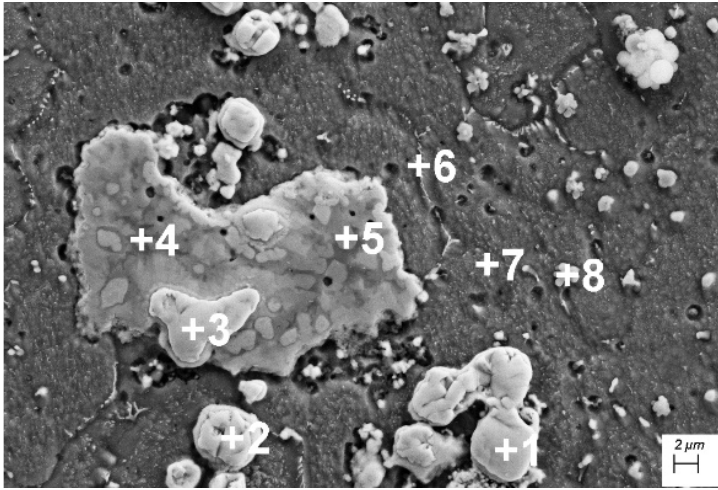
Figure 6. SE SEM image taken of the center area of the Cr75WC25 layer. Table 3. Chemical composition of the Cr75WC25 laser surface layers.